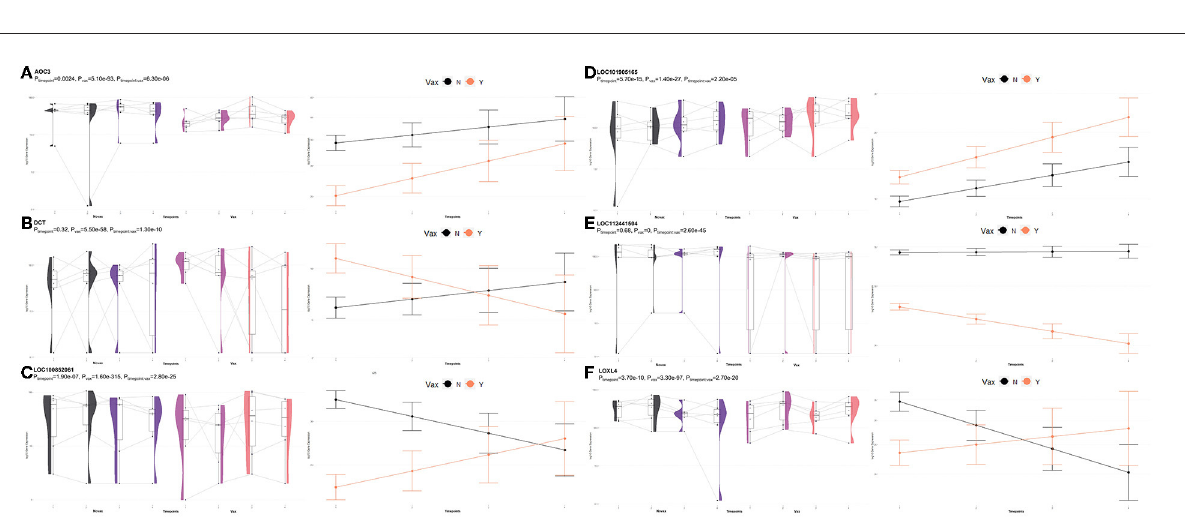
FIGURE11 Gene pairplots and modeled expression trends of key DEGs found in timepoint analyses. Pairplots (left side) demonstrate the log10 normalized gene expression of each sample across all timepoints, overlapped with a violin plot (depicting numerical distributions by density). Box-and-whisker plots represent median expression values (black line), the first (lower) and third quartiles (boxplot limits), 1.5 times the interquartile ranges (whiskers), and outlier expression levels for each timepoint (points outside whiskers). Modeled expression trends (right side) depict the overall differences between groups over each timepoint. Points represent the mean log10 normalized expression value for each group within a timepoint, and bars represent the standard error of log10 normalized expression for each group; orange represents the vaccinated group and black represents the non-vaccinated group. These plots depict the relative expression and glmmSeq level of significance for (A) AOC3 , (B) DCT , (C) , LOC100852061 ( KIR2DS2 ), (D) LOC101905165 ( NKG2D ), (E) LOC112441504 ( ULBP3 ), and (F) LOXL4